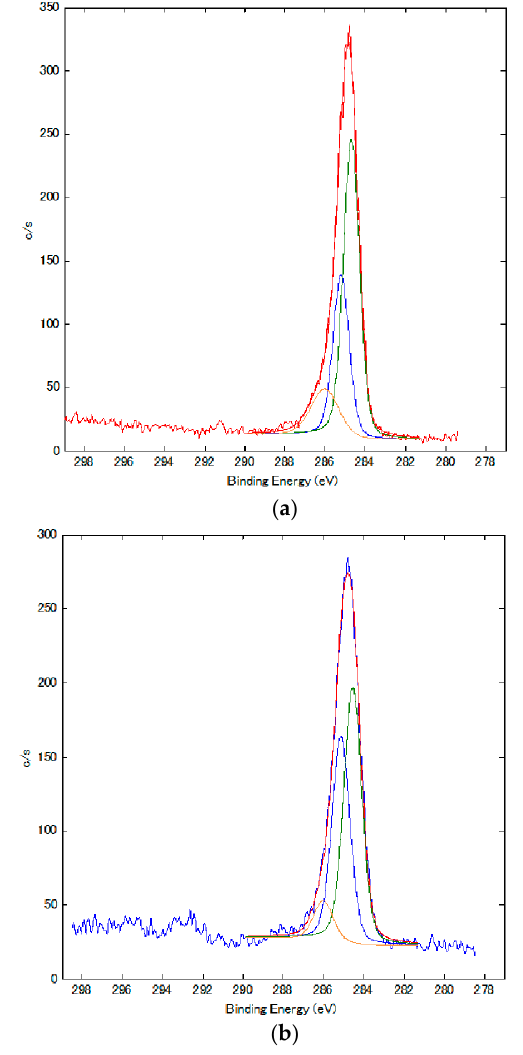
Figure 13. XPS spectra of MCF rubber of anode-side surface: ( a ) electrolytically polymerized MCF rubber; ( b ) MCF rubber solidified by the DM with a magnetic field.